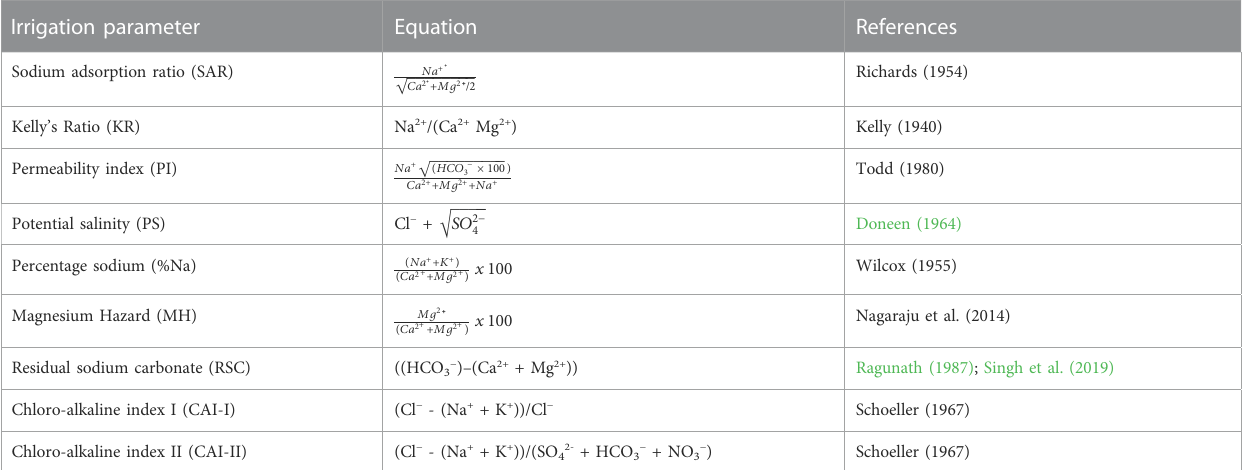
TABLE 2 Equations and references for irrigation water quality assessment. Irrigation